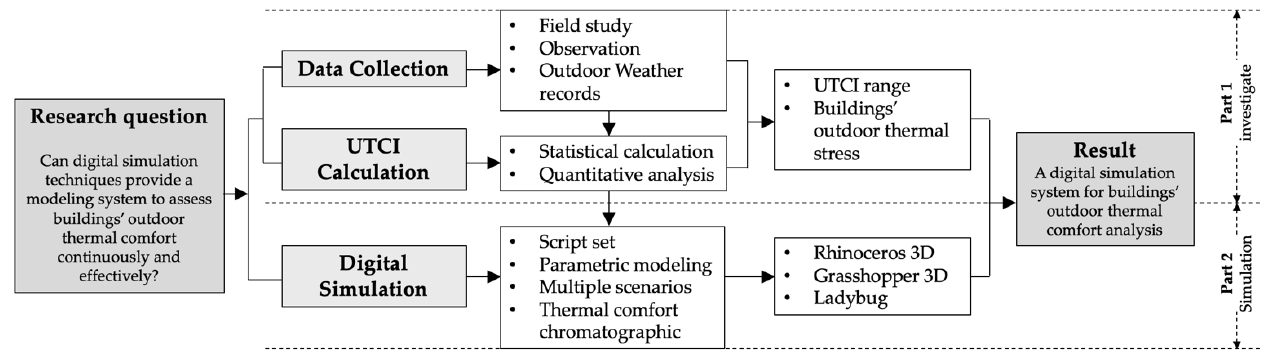
Figure 1. Research methodology framework.